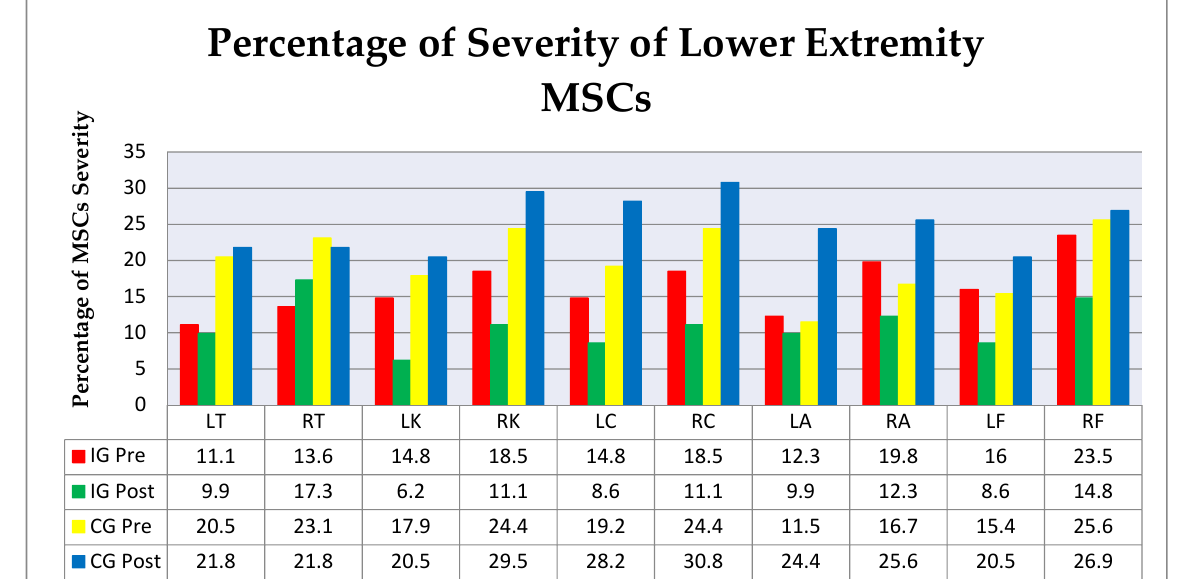
Figure 6. Percentage of lower extremity MSC severity. IG Pre—intervention group before the intervention; IG Post—intervention group after the intervention; CG Pre—control group before the intervention; CG Post—control group after the intervention